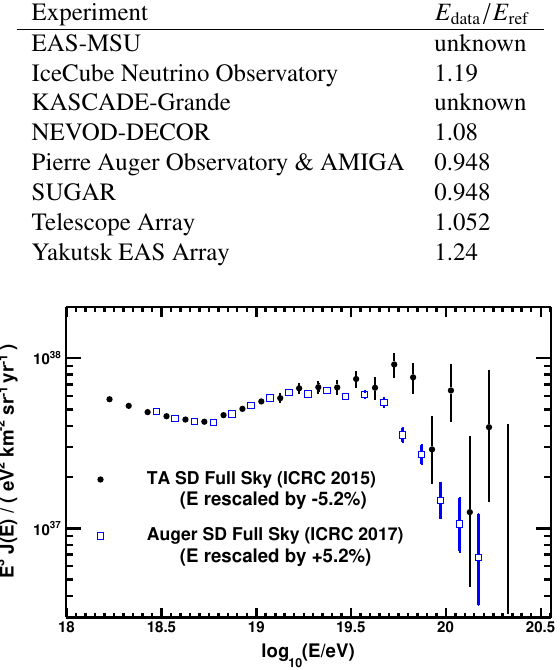
Table 1. Energy-scale adjustment factors obtained from cross-calibration. The cross-calibration is explained in the text.